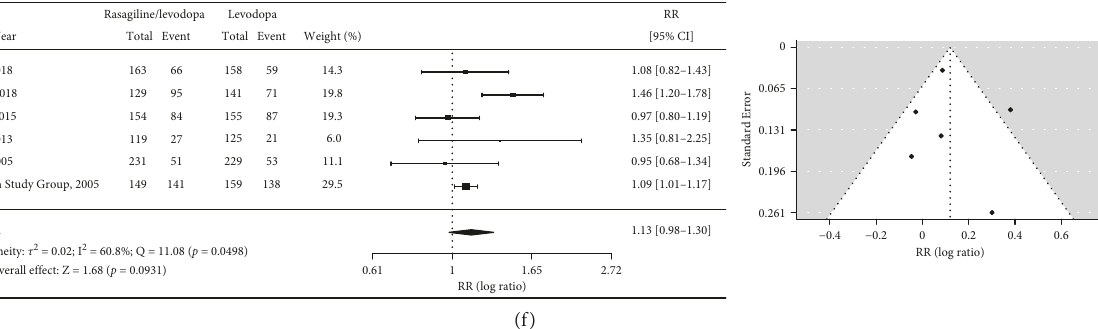
Figure 3: Forest plots and funnel plots for treatment effects of rasagiline/levodopa combination therapy versus levodopa monotherapy on (a) wearing-off time (hours), (b) levodopa dosage (mg/day), (c) UPDRS/MDS-UPDRS II score, (d) UPDRS/MDS-UPDRS III score, (e) PDQ-39 summary index score, and (f) incidence of TEAEs. CI, confidence interval; MDS-UPDRS, Movement Disorder Society-Unified Parkinson’s Disease Rating Scale; PDQ-39, Parkinson’s Disease Questionnaire; RE, random effect; RR, risk ratio; SD, standard deviation; SMD, standardized mean difference; TEAE, treatment-emergent adverse event; UPDRS, Unified Parkinson’s Disease Rating